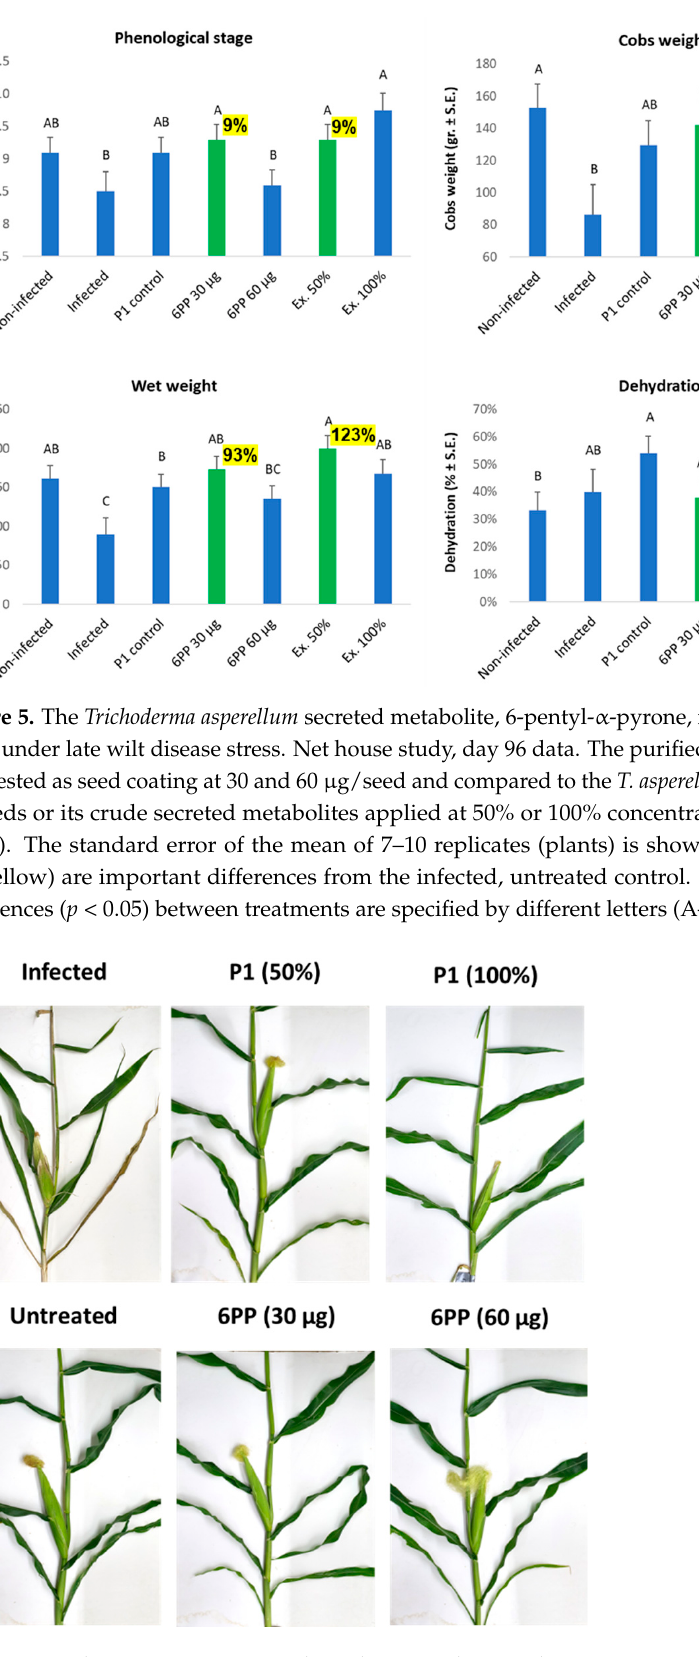
Figure 6. Net house representative plant photos on day 96. The experiment’s treatments and controls are depicted in Figure 5.